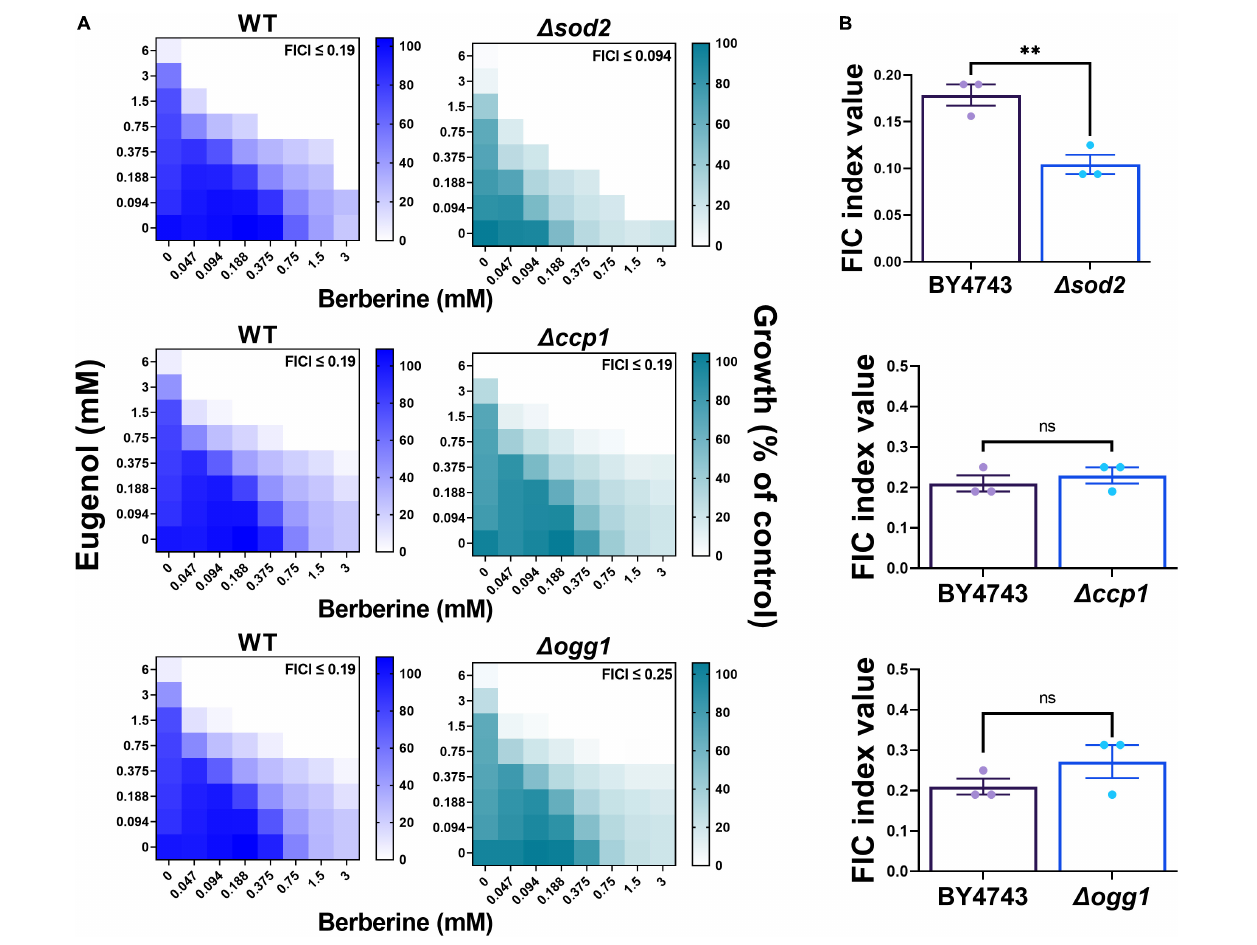
FIGURE 7 | Eugenol plus berberine synergy in deletion strains defective for mitochondrial antioxidant proteins. (A) Checkerboard assays of combinatorial growth effects performed according to the EUCAST procedure in YPD broth within S. cerevisiae BY4743 (WT) and isogenic deletion mutants (cid:49) sod2 , (cid:49) ccp1 , and (cid:49) ogg1 at the indicated concentrations of eugenol and berberine. The growth values represent the mean of three independent experiments calculated as percentages of growth (OD 600 ) with the natural products relative to the minus-NP control, after 24 h at 30 ◦ C. FICI, fractional inhibitory concentration index, calculated from the data and where growth < 5% of the control was assigned as no-growth (Hsieh et al., 1993). (B) FIC indices are plotted from three independent checkerboard experiments, with bar-height showing mean ± SEM. ∗∗ p < 0.01, unpaired t -test. ns, not